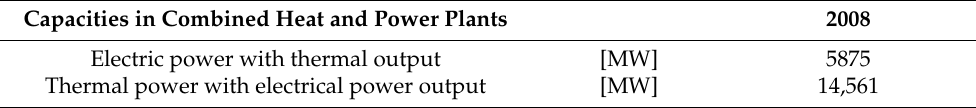
Table 1. Thermal and electrical capacities in combined heat and power plants.